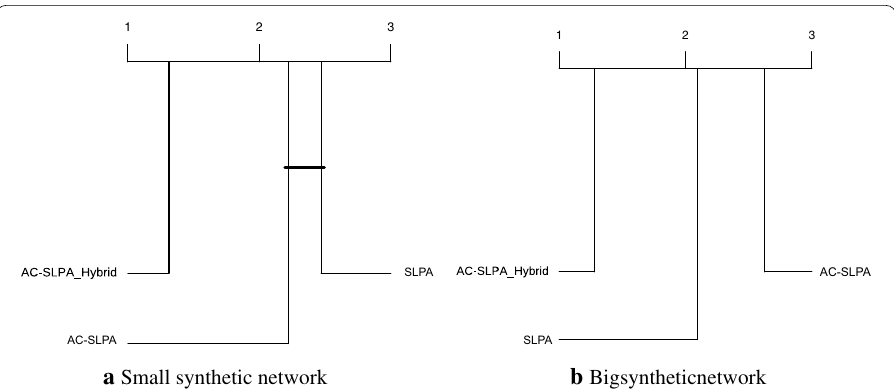
Fig. 12 Critical difference plots from Friedman aligned rank test with Finner p value correction with significance level α = 0.05 comparing Hybrid (the best performing variant from the previous experiment), SLPA and AL-SLPA algorithms on small and large synthetic networks. Algorithms which are not connected with the horizontal dark line are significantly different than each other. Lower ranks indicate better overall